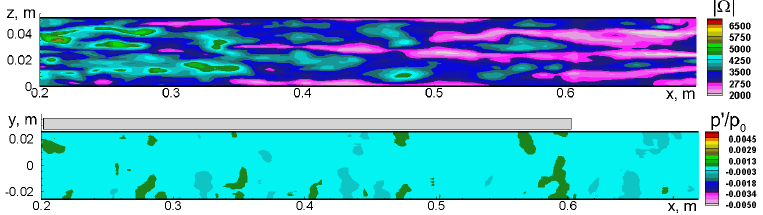
Figure 8. Instantaneous fields of vorticity magnitude at the upper (lined) wall and pressure fluctuations in a meridian plane from WMLES of the flow in the GIT without external acoustic signal with the use of stabilization body force SRC 1 (7) at B D = 0.4. Compare these fields with the corresponding fields in Figure 1a,c.